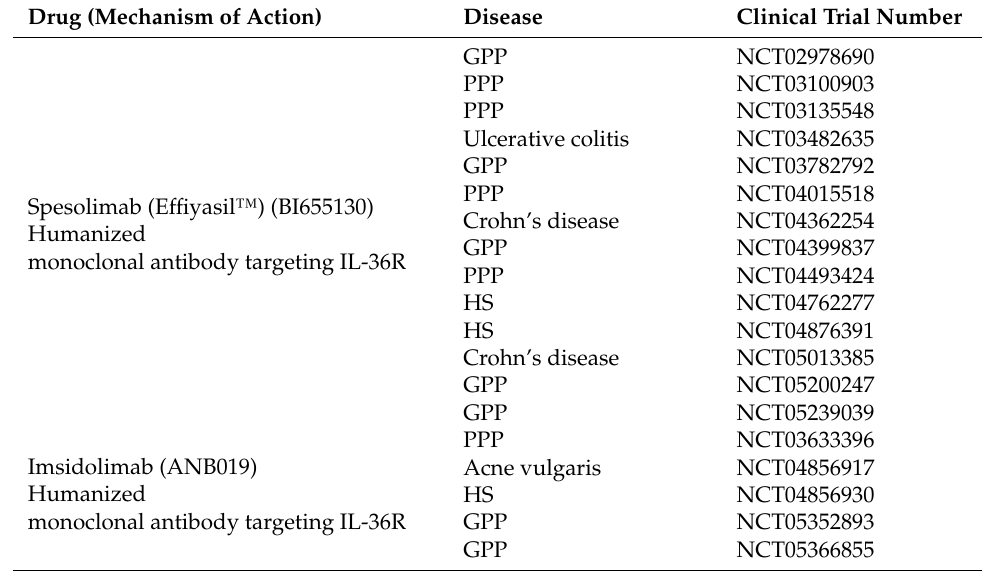
Table 2. Ongoing clinical trials of anti-IL36R inhibitors